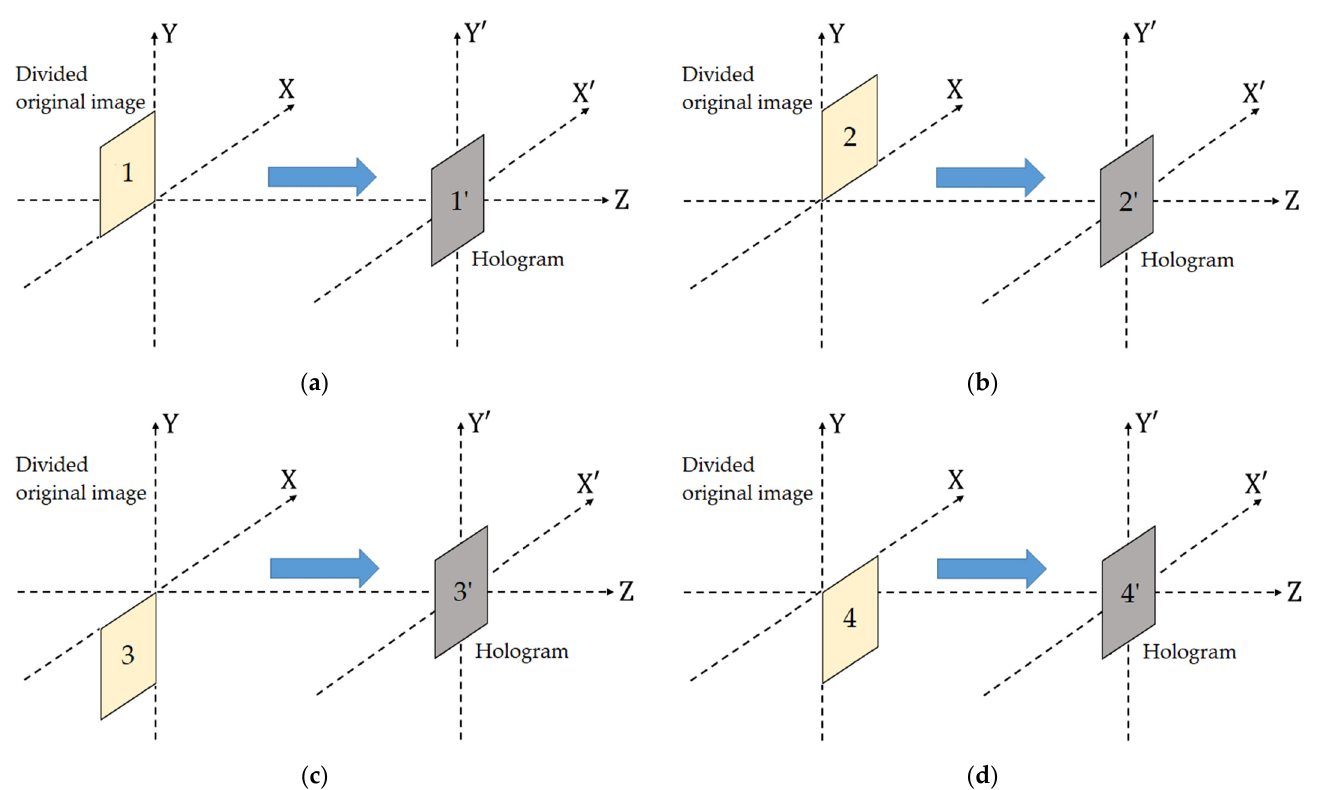
Figure 3. Recording of CGH using time-division reconstruction method: ( a ) recording of divided original image 1,